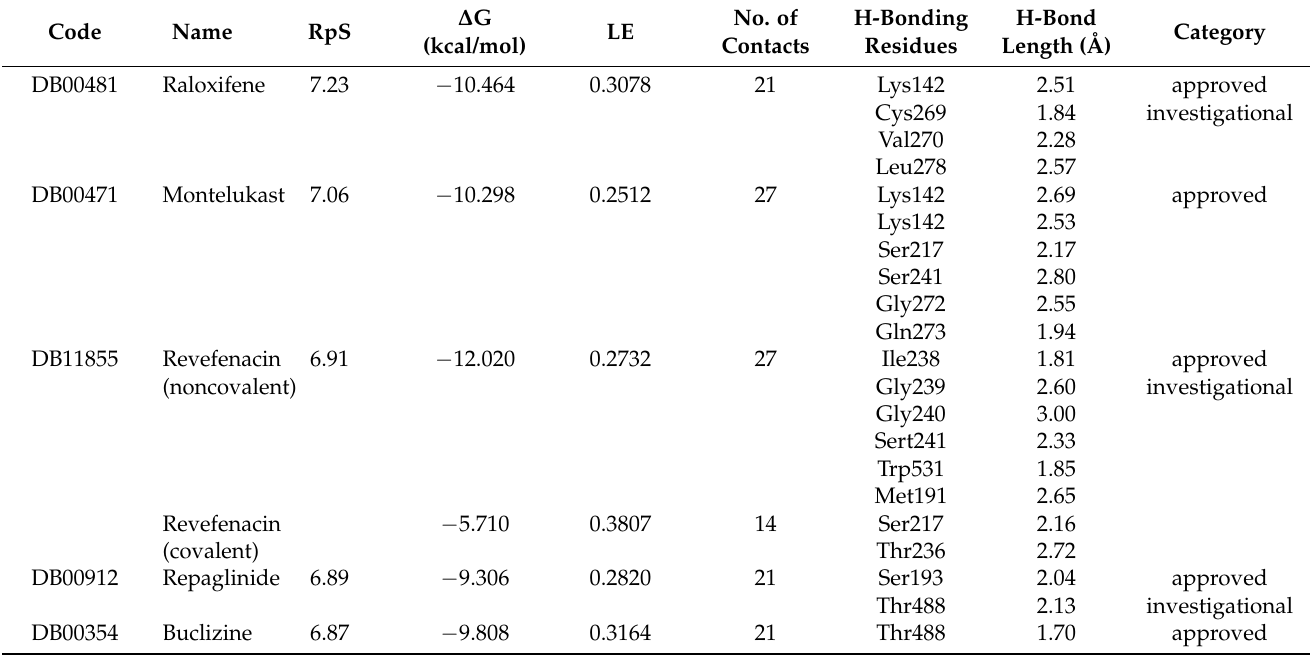
Table 4. Top potential repurposing candidates based on the RpS and molecular docking score values and on the toxicological